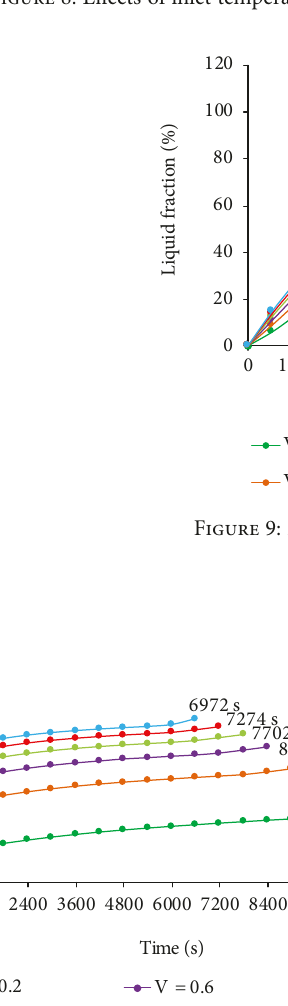
Figure 8: E ff ects of inlet temperature of HTF on the total stored energy capacity and energy storage rate.